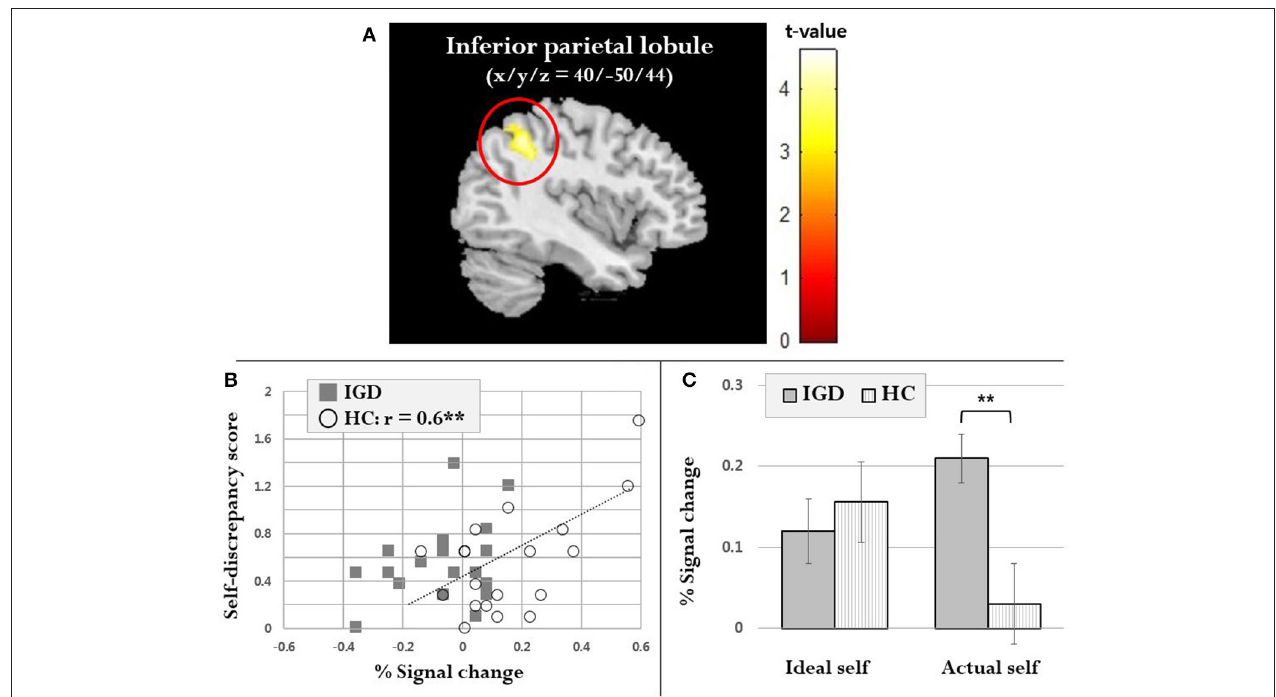
FIGURE 3 | Neural responses during the self-concept task. As shown in (A) , individuals with internet gaming disorder (IGD) showed significantly lower inferior parietal lobule (IPL) activity in the self-discrepancy contrast than healthy controls (HC). The correlation between IPL activity in the self-discrepancy contrast and behavioral data is displayed in (B) . IPL activity in the ideal self and actual self conditions in each group is displayed in panel (C) . ** p <